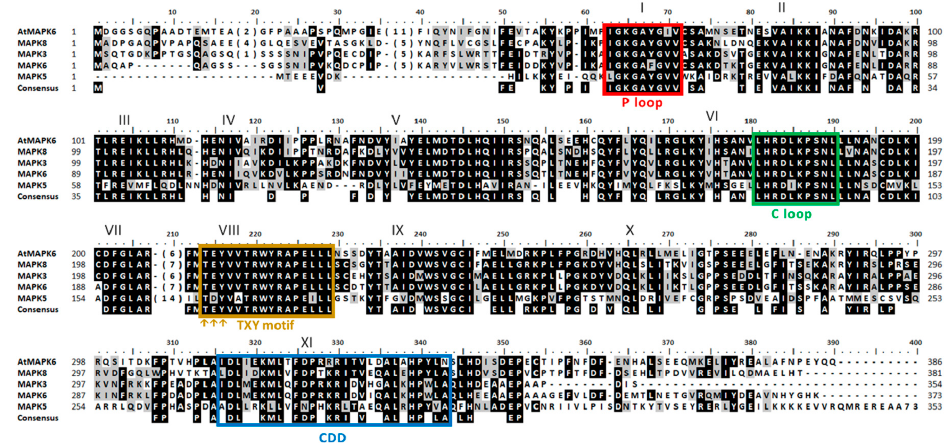
Figure 3. Sequence alignment of Arabidopsis MAPK6 with the most closely related Chlamydomonas MAPK. For other details see Figure 1.